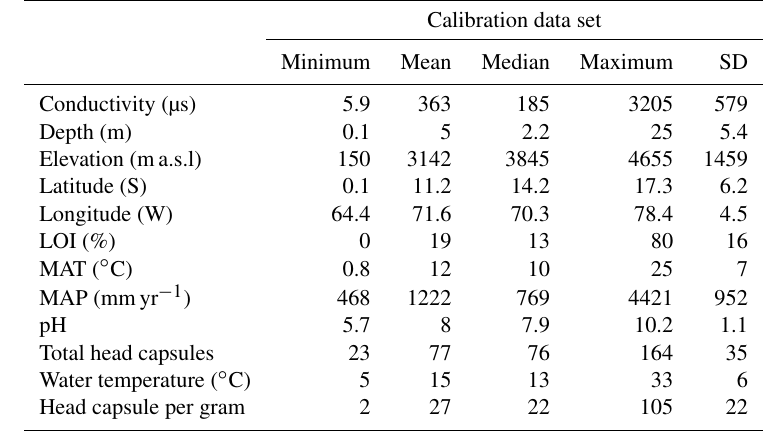
Table 1. Summary of the physical and chemical properties of the 59 calibration data set lakes including the total number of head capsules retrieved from each lake and the concentration of head capsules per gram of sediment. MAT: mean annual temperature; MAP: mean annual precipitation; LOI: loss on ignition (550 ◦ C).